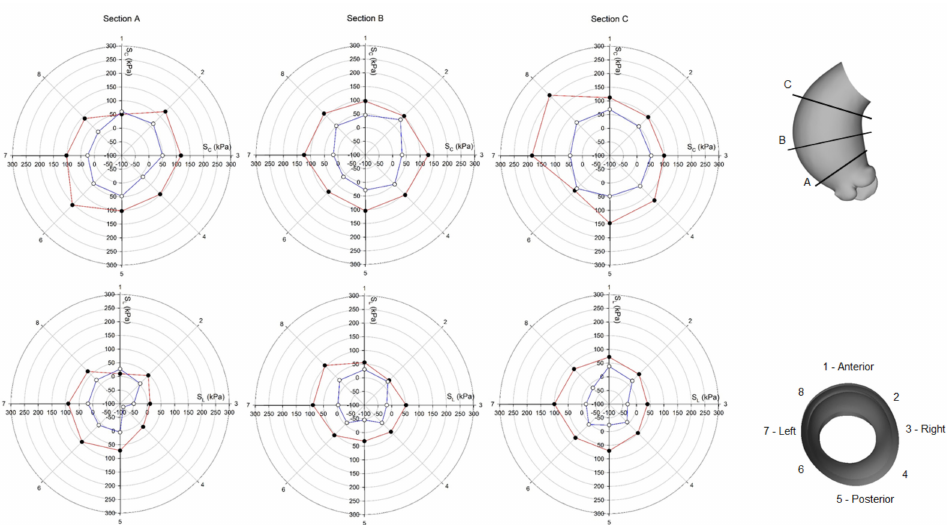
Figure 8. Polar plot of stress distribution along three different sections for healthy LHHM at systolic peak for both the inner aortic wall surface (red lines) and the outer aortic wall surface (blue lines).